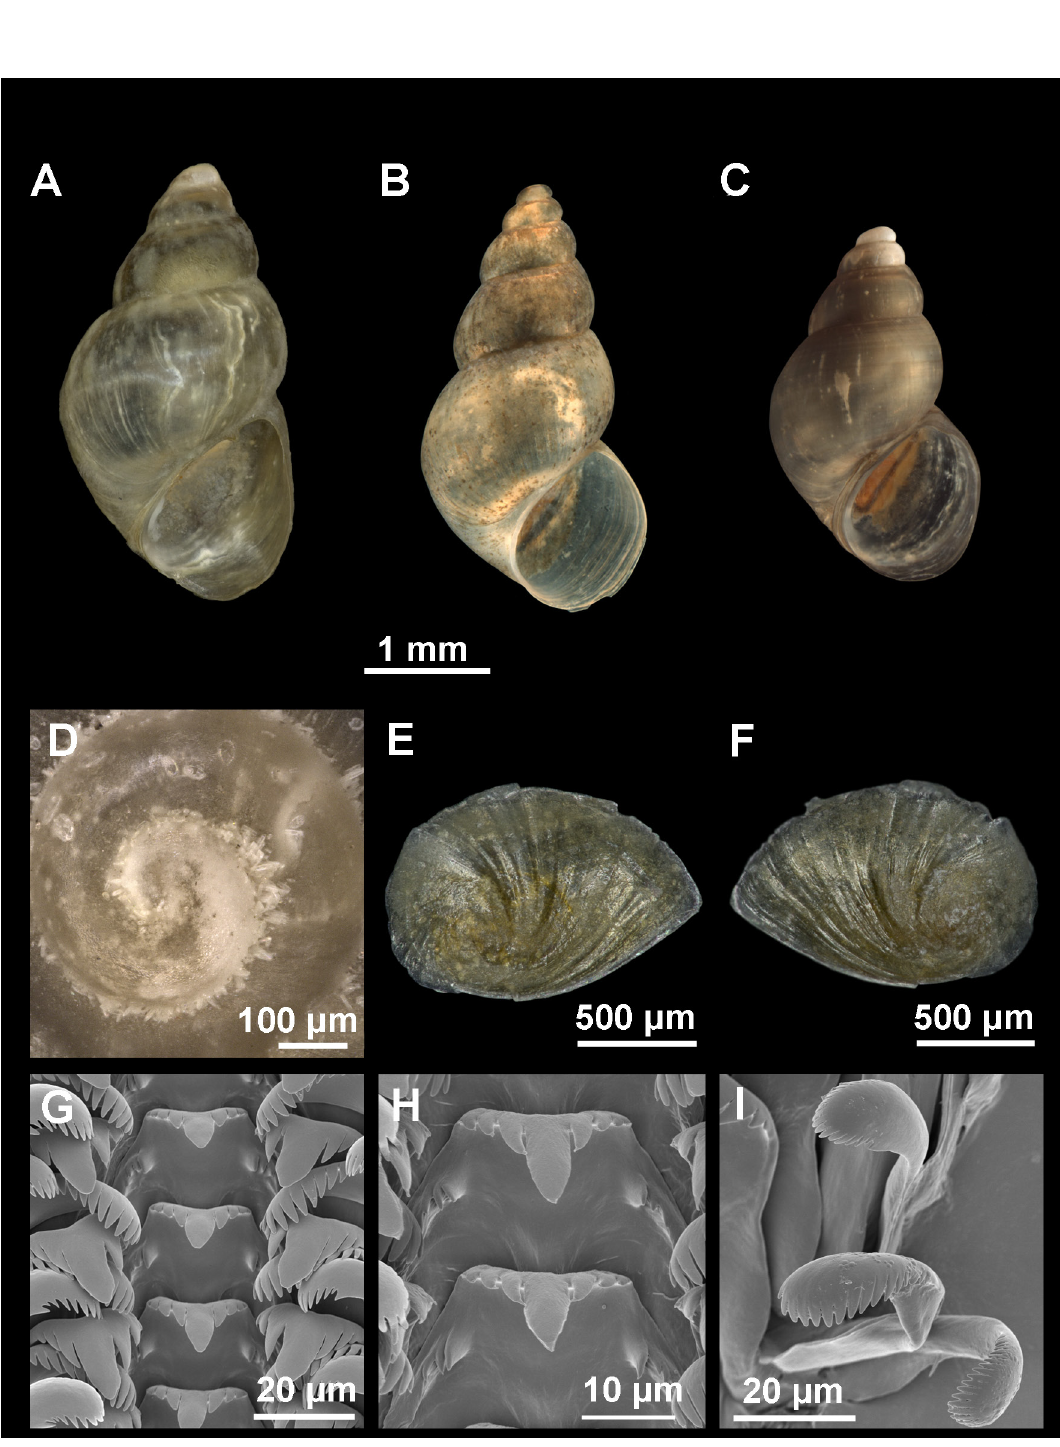
Fig. 8. Shell, operculum and radula of Shadinia terpoghassiani (Shadin, 1952) from Lake Aiger-Lich, Armenia. A–C . Shell in front view. D . Protoconch and microsculpture. E–F . Internal and external side of the operculum. G . Rows of teeth of the radula. H . Central teeth. I . Detail of outer